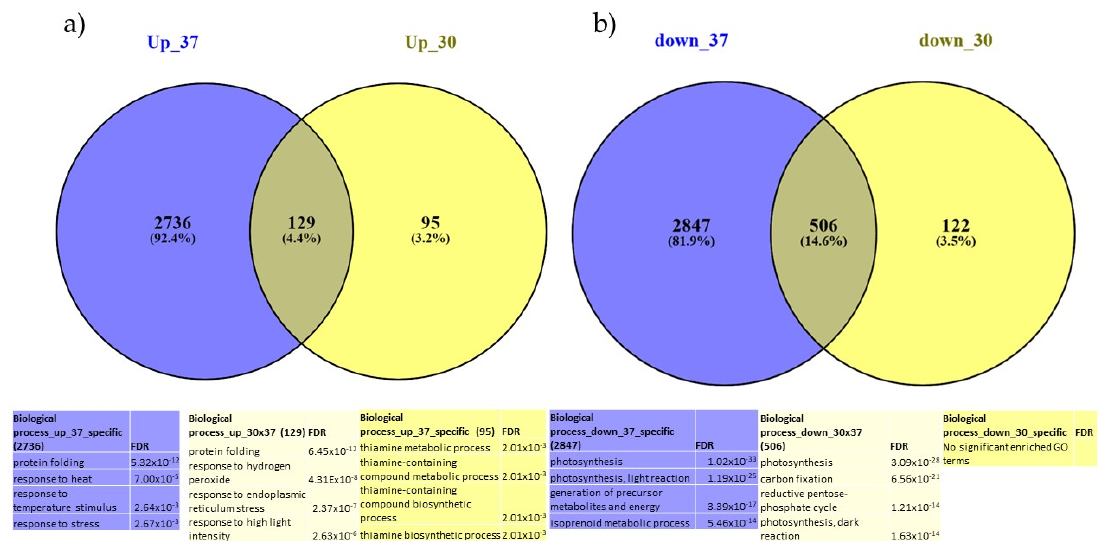
Figure 2. Venn diagram of expression data analysis at 37 °C and 30 °C of the ( a ) up-regulated genes and ( b ) down-regulated genes; and associated GO terms. Up_30 = DEG up-regulated at 30 °C at all time points, down_30 = DEG down-regulated at 30 °C at all time points. Up_37 = DEG up-regulated at 37 °C at all time points, down_37 = DEG down-regulated at 37 °C at all time points.